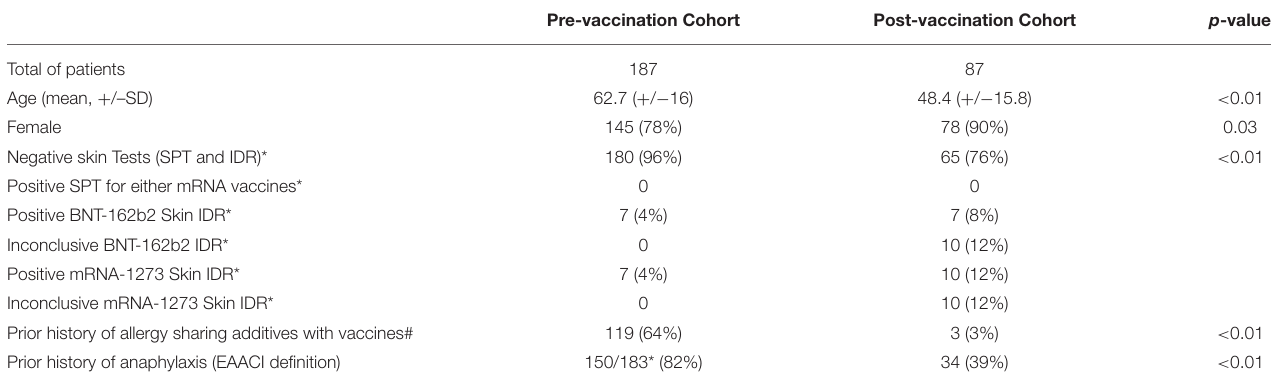
TABLE 1 | Characteristics of patients included in the pre- and post-vaccination cohort. Pre-vaccination Cohort Post-vaccination Cohort p -value